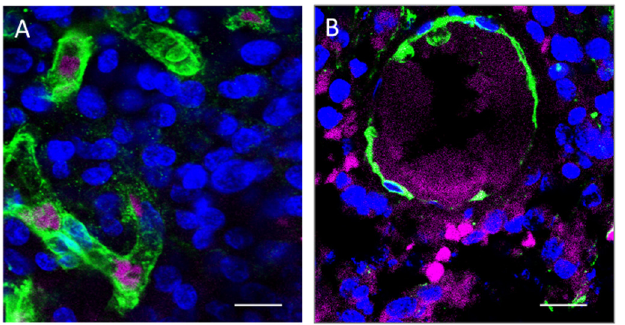
Figure 2. Fluorescence microscopy for 5-ALA and lectin. ( A ) In low-grade gliomas (Case #2 on Table 1), 5-ALA fluorescent cells (purple) can be found occasionally within vascular structures (green). Scale bar, 20 μ m. ( B ) In high-grade gliomas (Case #5 on Table 1), several 5-ALA fluorescent cells (purple) are seen outside blood vessels (green) whose wall appears discontinuous. Scale bar, 30 μ m. Objective lens, Olympus PlanApo N 60×/1.42 Oil.